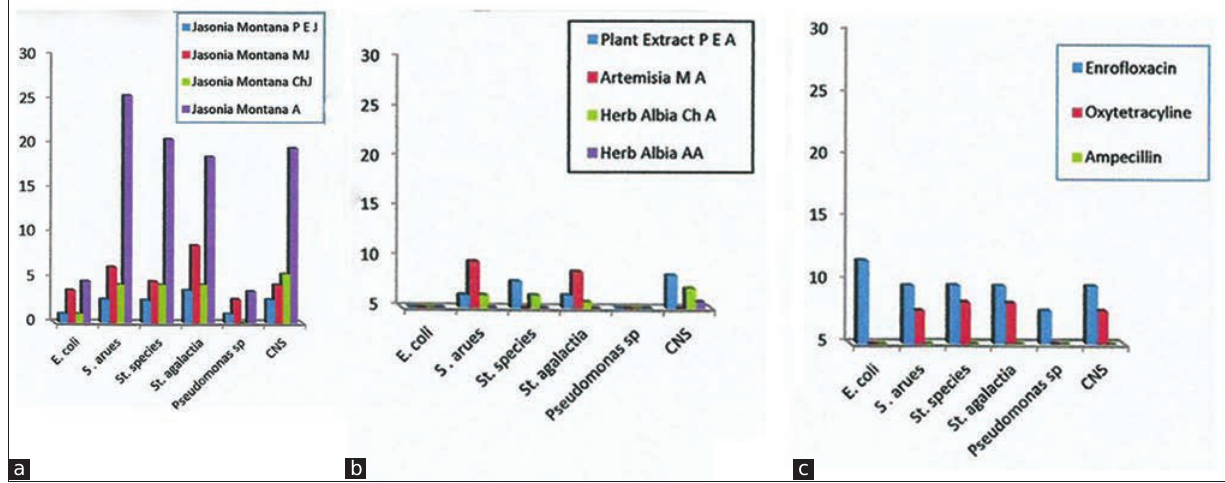
Figure-3: (a) Revealed that the Jasonia montana plant acetone extract showed the highest antibacterial effect on Staphylococcus aureus , Streptococcus ssp . and coagulase-negative Staphylococci, other extracts have antibacterial effect on the same bacteria but still lower than acetone extract. (b) the Artemisia herb alba had moderate effect on Gram-positive bacteria, (c) antibiotic showed antibacterial effect on Gram-negative and Gram-positive bacteria.